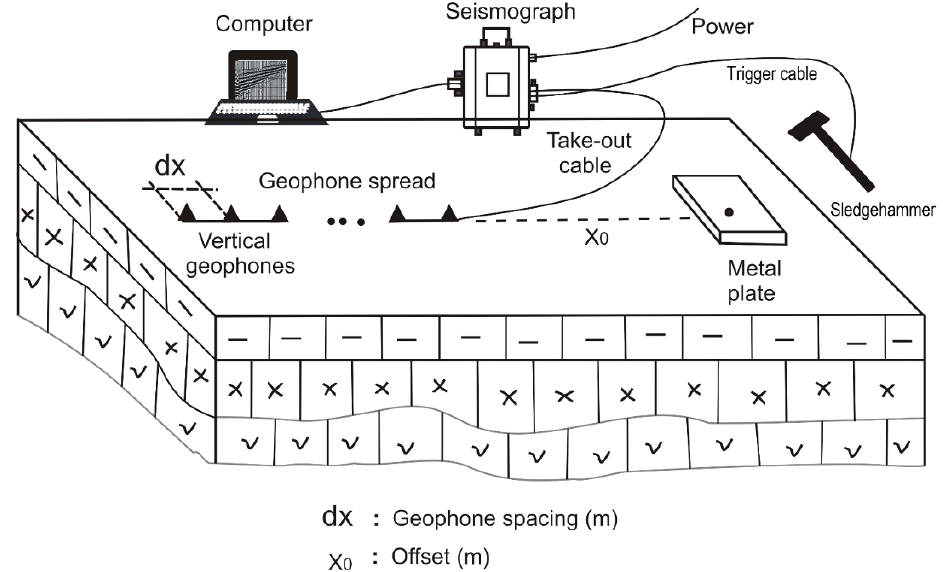
Figure 2. The field acquisition geometry for the P and SV waves. The energy source (a sledgehammer vertically hitting the metal plate) and vertical geophones are shown. Both source and receivers (geophones) are placed on the